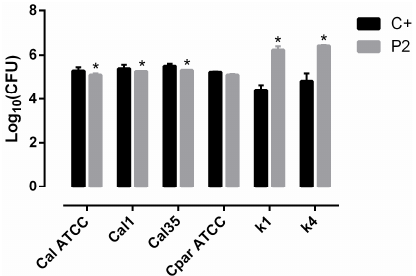
Figure 3. Adherence study of yeasts attached to the uncoated (C+) or coated (P2) bottom of a P6 well plate. Data are represented as log 10 (median of CFU) estimated in three biological replicates *: p < 0.05 for Wilcoxon test between the two compared conditions. The bars represent median and interquartile range of log 10 (CFU) estimated in three biological replicates. Cal ATCC: C. albicans ATCC 10231. Cpar ATCC: C. parapsilosis ATCC 22019.